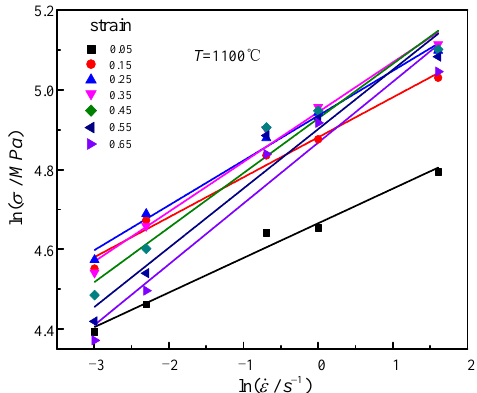
. ε and ln σ at 1100 ◦ C. Figure 4. Relationships between ln  and ln  at 1100 °C.